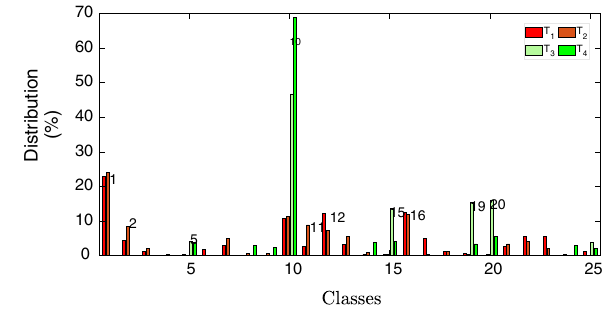
Fig. 6 Distribution over the classes